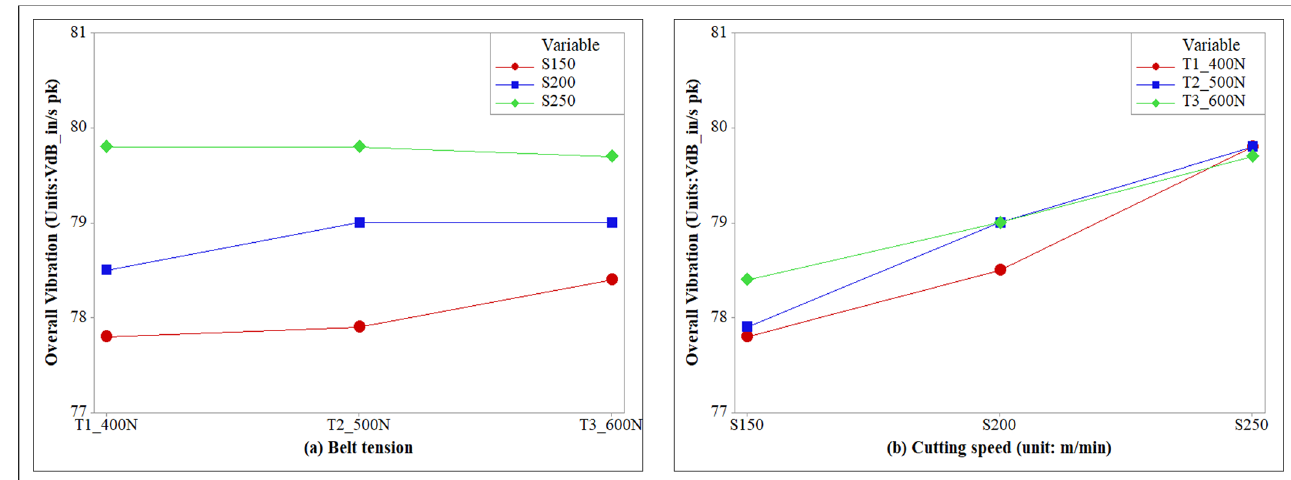
Figure 5. Results of frequency analysis of measured vibrations. ( a ) Frequency analysis of servomo ‐ tor; ( b ) frequency analysis of cooling fans; ( c ) frequency analysis of spindle; and ( d ) frequency anal ‐ ysis of hydraulic pump.